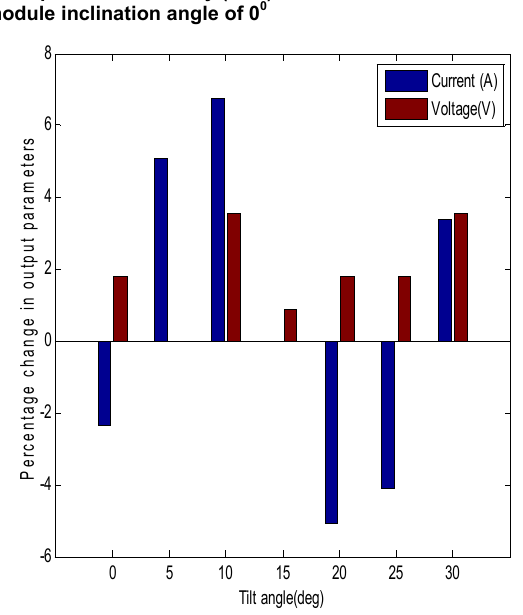
Figure 5. Current variation with voltage under same Isotropic and reflectivity (0.75) in different locations for module inclination angle of 0 0